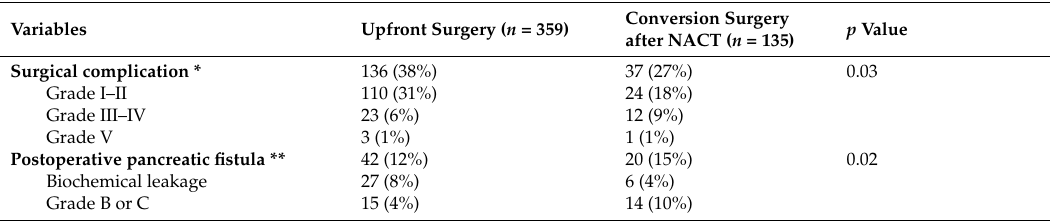
Table 3. Postoperative complications.